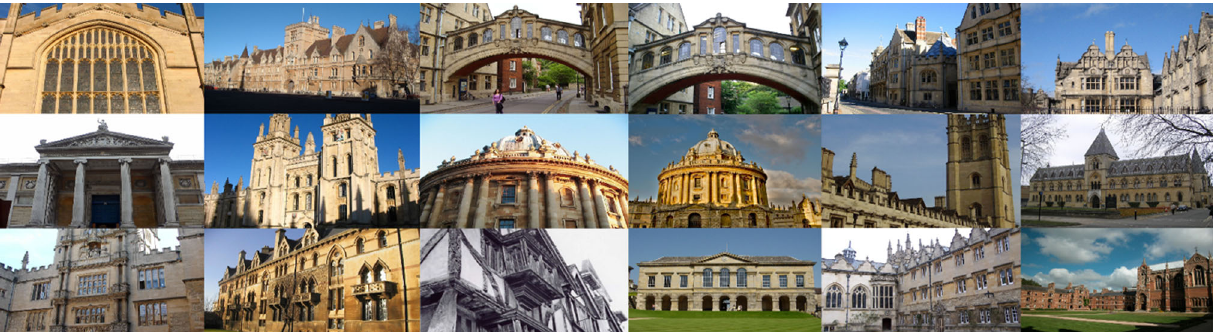
Fig. 14 Sample images of the oxford building